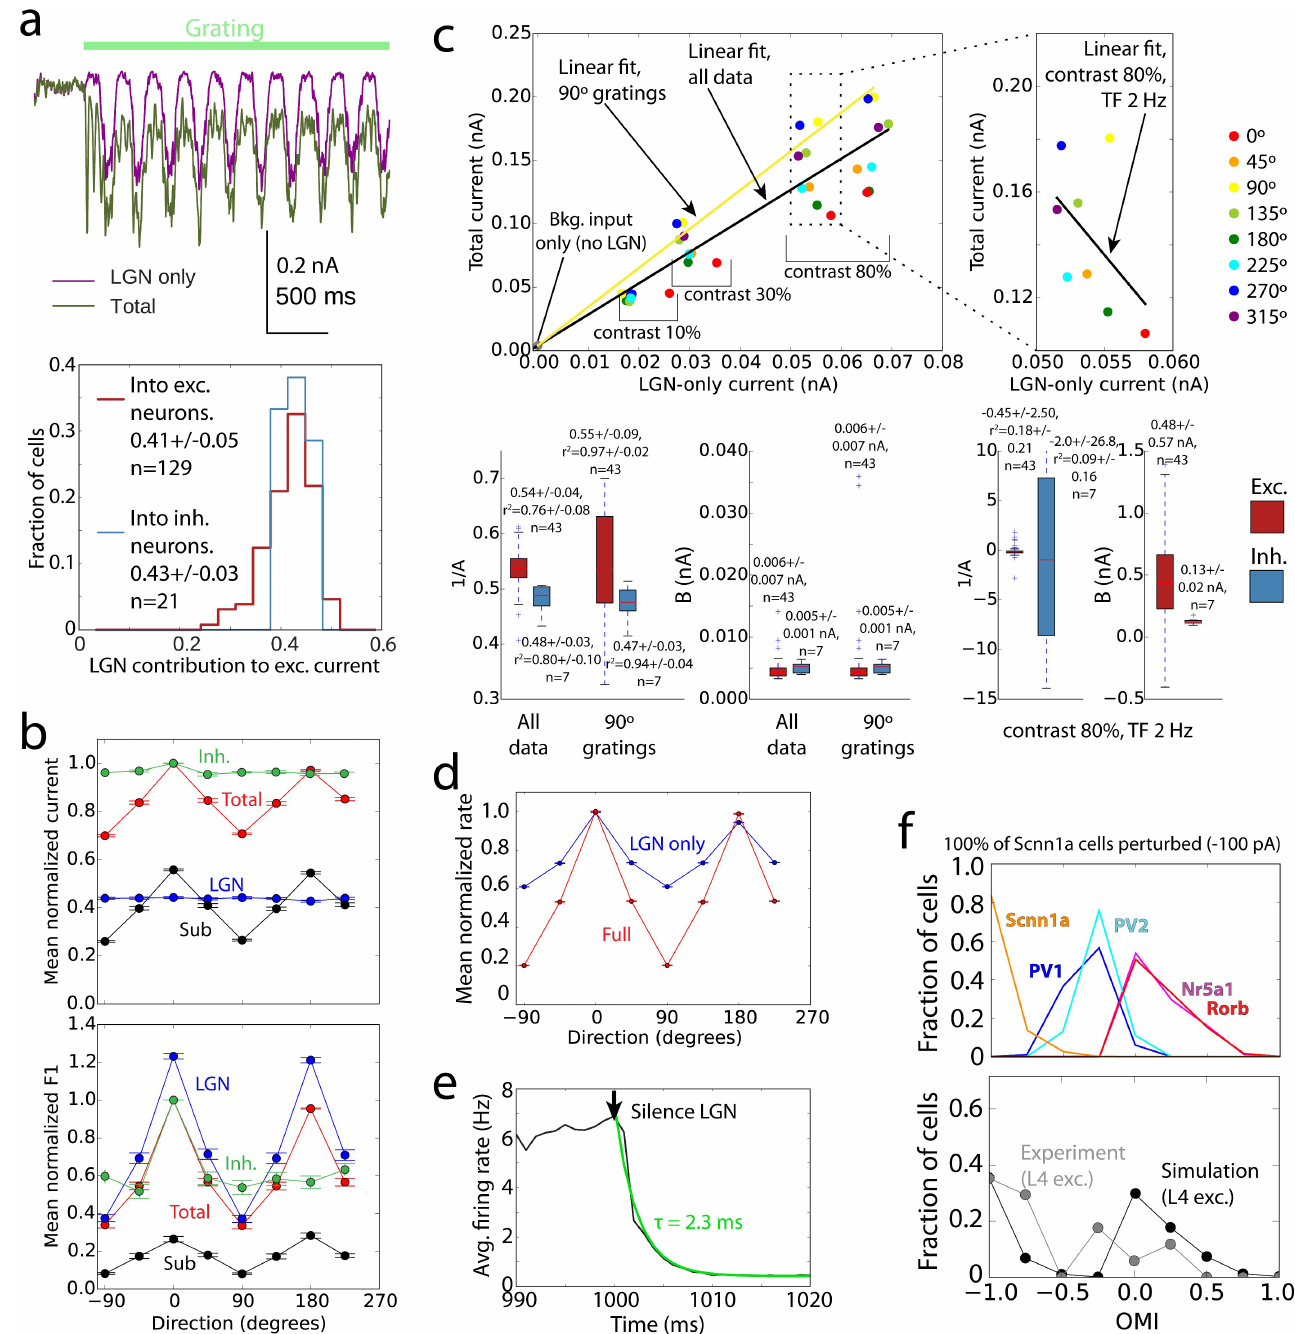
Fig 4. Mechanistic characterization of the model. (a) Cortical amplification of the LGN inputs. The excitatory currents (from the LGN only, as well as total) in biophysical cells were measured using voltage clamp recordings. Top–an example; bottom–distributions of LGN contribution to the total excitatory current across excitatory and inhibitory cells (computed for each cell as the average current over time and over all trials of the preferred orientation). (b) Tuning curves for the mean and F1 component of the total and LGN-only currents, and their difference (“Sub”, i.e., the cortical component), as well as inhibitory current. The data for each cell were normalized to the peak value of the “Total” and shifted so that the preferred direction is at 0 degrees; averages and s.e.m. over all recorded excitatory cells are shown (TF = 2 Hz, contrast 80%). The inhibitory currents were normalized and aligned to their own peak values, since their magnitude is significantly higher than that of excitatory currents. (c) Amplification of excitatory current. Top, the total current vs. the LGN-only current, for an individual Rorb cell (each point is an average over time and over 10 trials). Linear fits ( I tot = A I LGN + B ) are shown for data aggregated from all grating directions, TFs, and contrasts (black), for one selected direction (yellow), and for a fixed contrast and TF (i.e., representing a sample direction tuning curve; right plot). Bottom, summary of linear fits across all cells analyzed. (d) Tuning curves for mean firing rate in full network simulations (“Full”, red) and in simulations where all